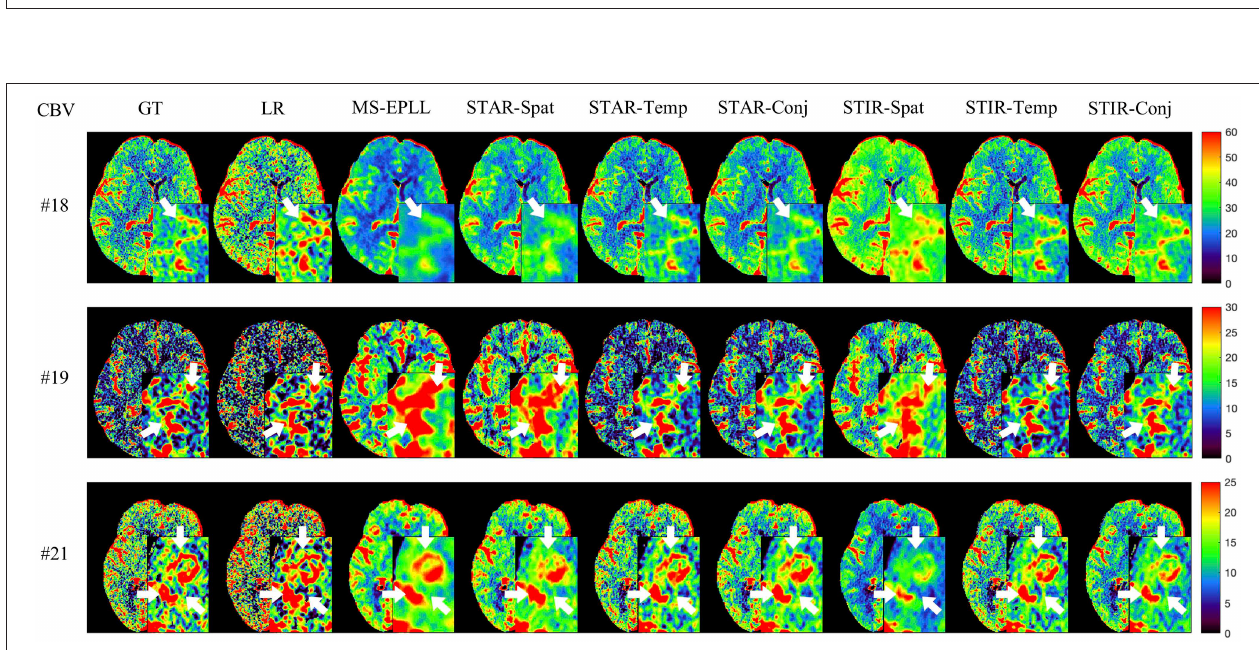
Frontiers in Neurology |